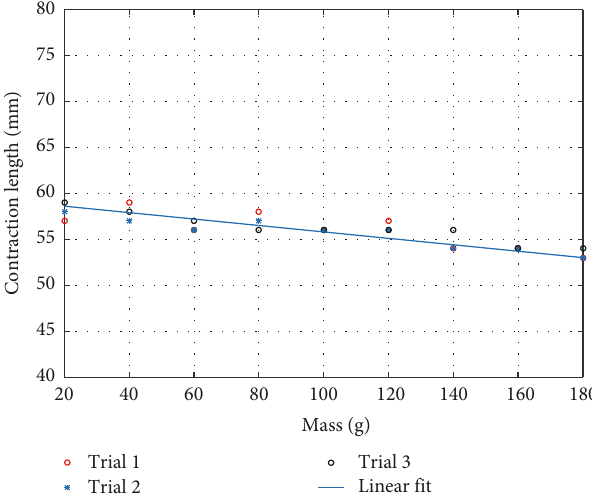
Figure 11: Linear regression of load-displacement experimental data (the di ff erent shaped dots represent the results of three repetitions of the